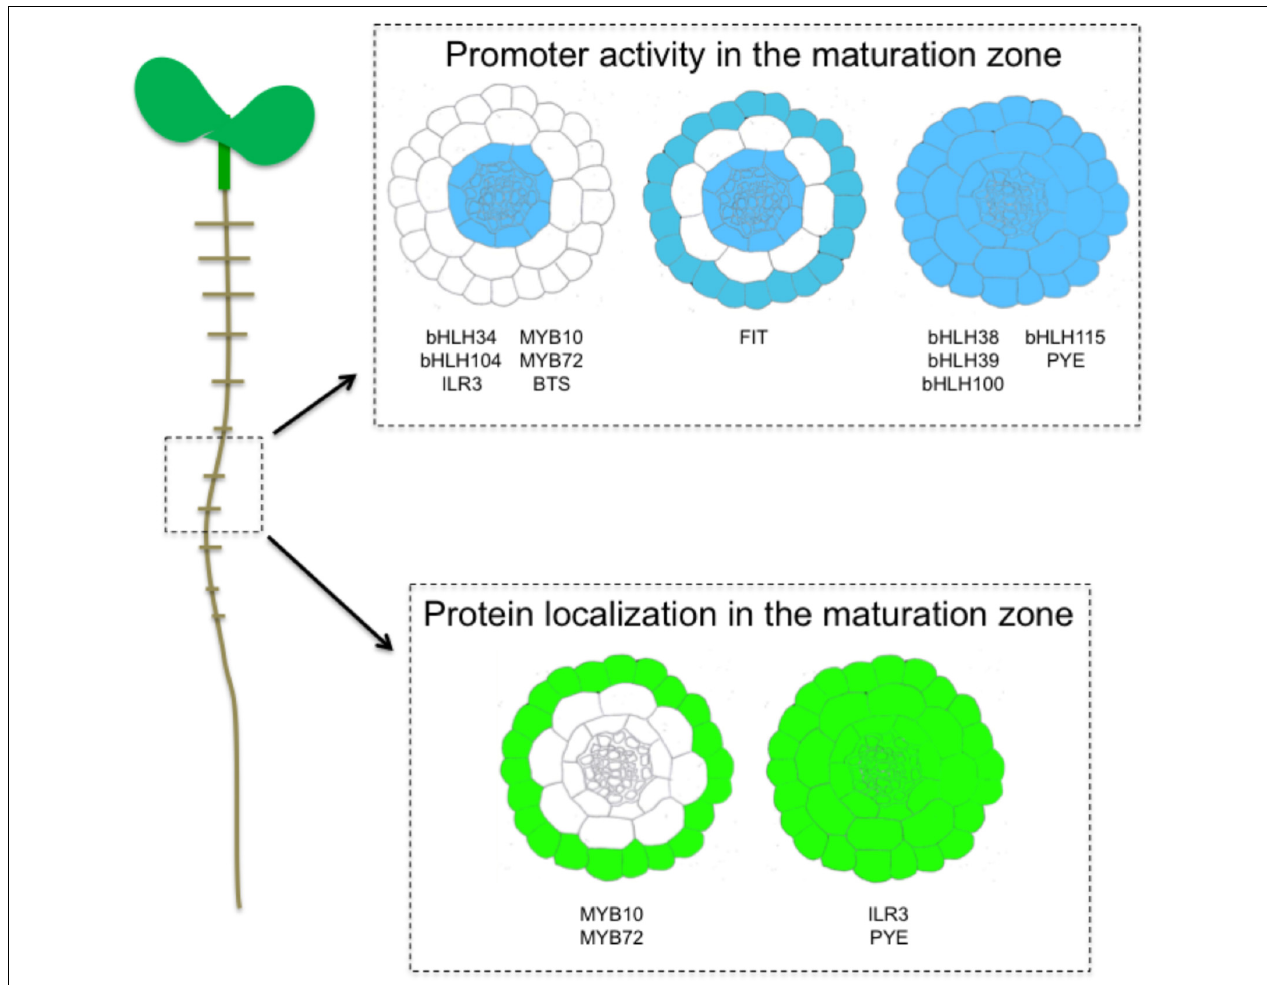
FIGURE 2 | Schematic representation, based on previous studies, of expression (promoter activity) and localization (GFP fusion) pattern of transcription factors involved in the response to iron deficiency, in the maturation zone of the A. thaliana roots.